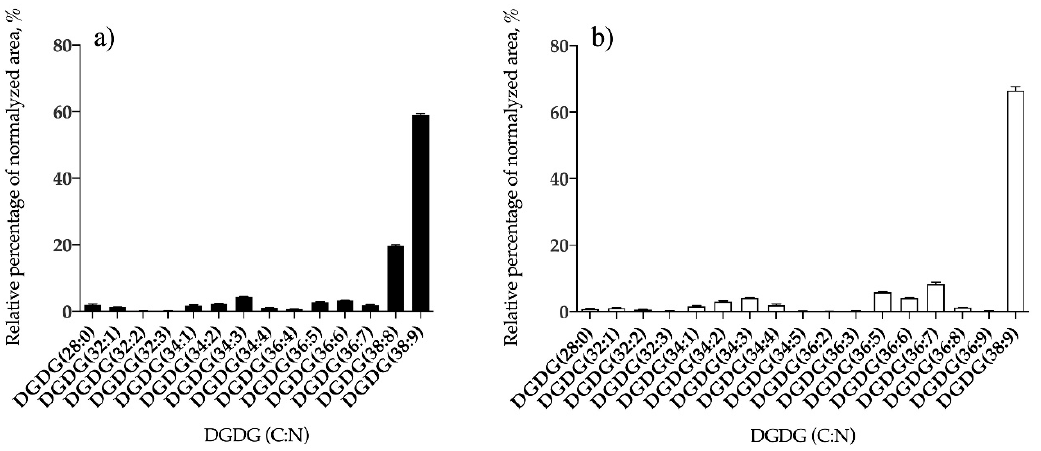
Figure 3. Relative abundances (RA) of lipid species of digalactosyl diacylglycerol (DGDG) glycolipids identified in B. bifurcata ( a ) and S. muticum ( b ). The results are expressed as relative percentage after dividing the normalized peak area of each lipid species to the sum of normalized peak areas for all the lipid species within the class obtained after LC–MS analysis. Numbers in parentheses (C:N) indicate the number of carbon atoms (C) and double bounds (N) in the fatty acid side chains. The species with higher RA was DGDG (38:9) for both seaweeds. Betaine lipids identified in B. bifurcata and S.